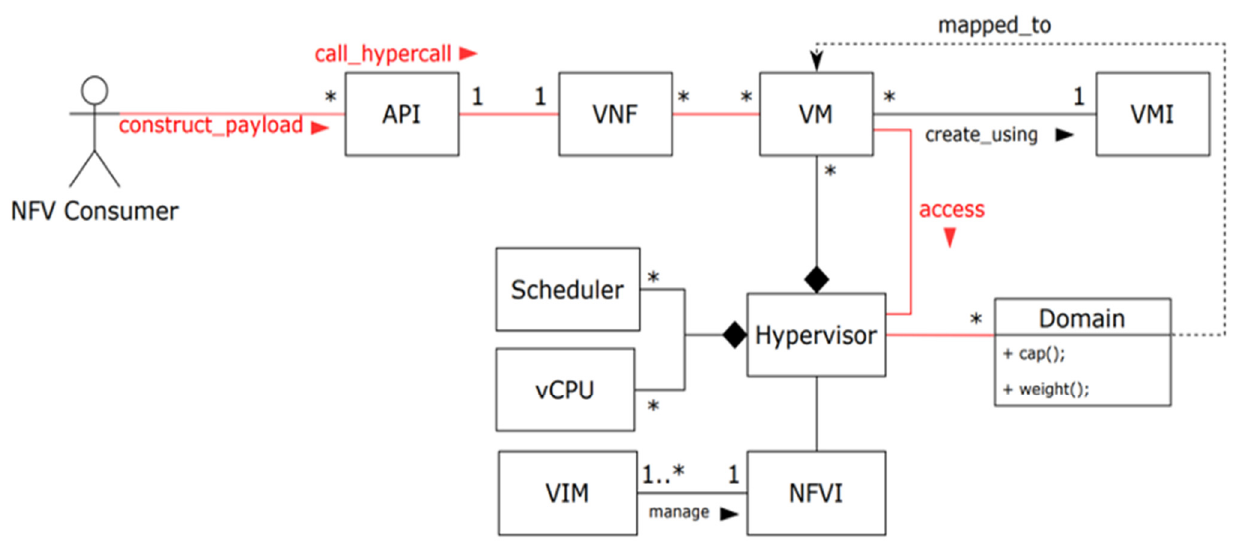
Figure 2. Class diagram for modifying a non-control attack in NFV.